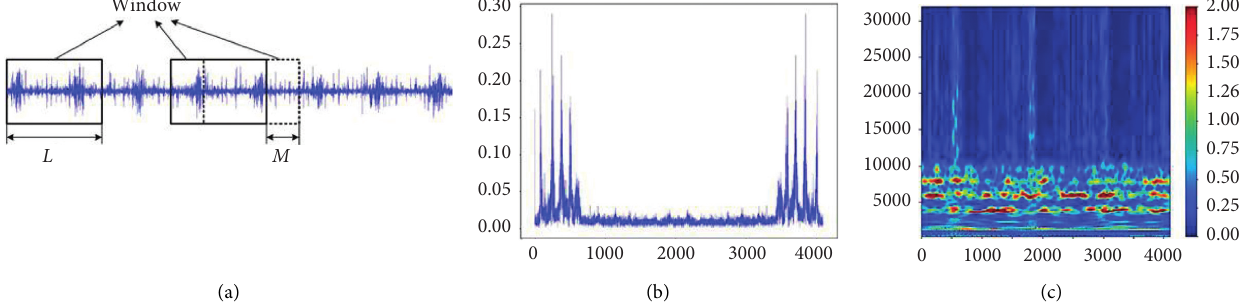
Figure 2: Primary feature extraction: (a) temporal feature, (b) frequency feature, and (c) time-frequency